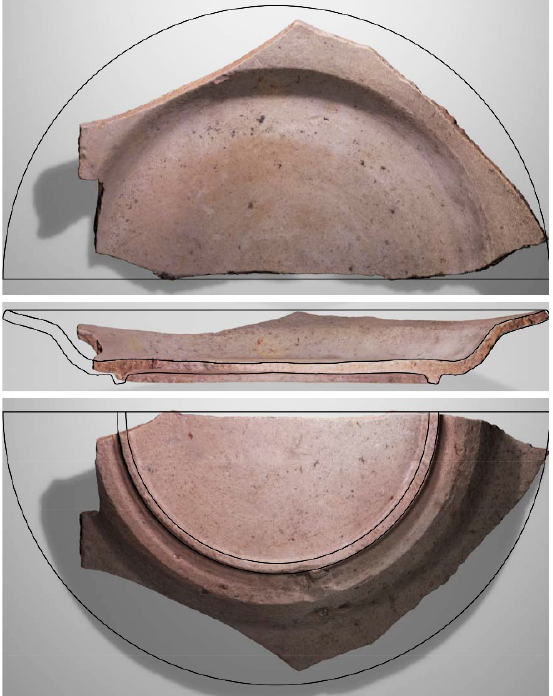
Figure 4: Orthometric representation of the plate, using cast and attached